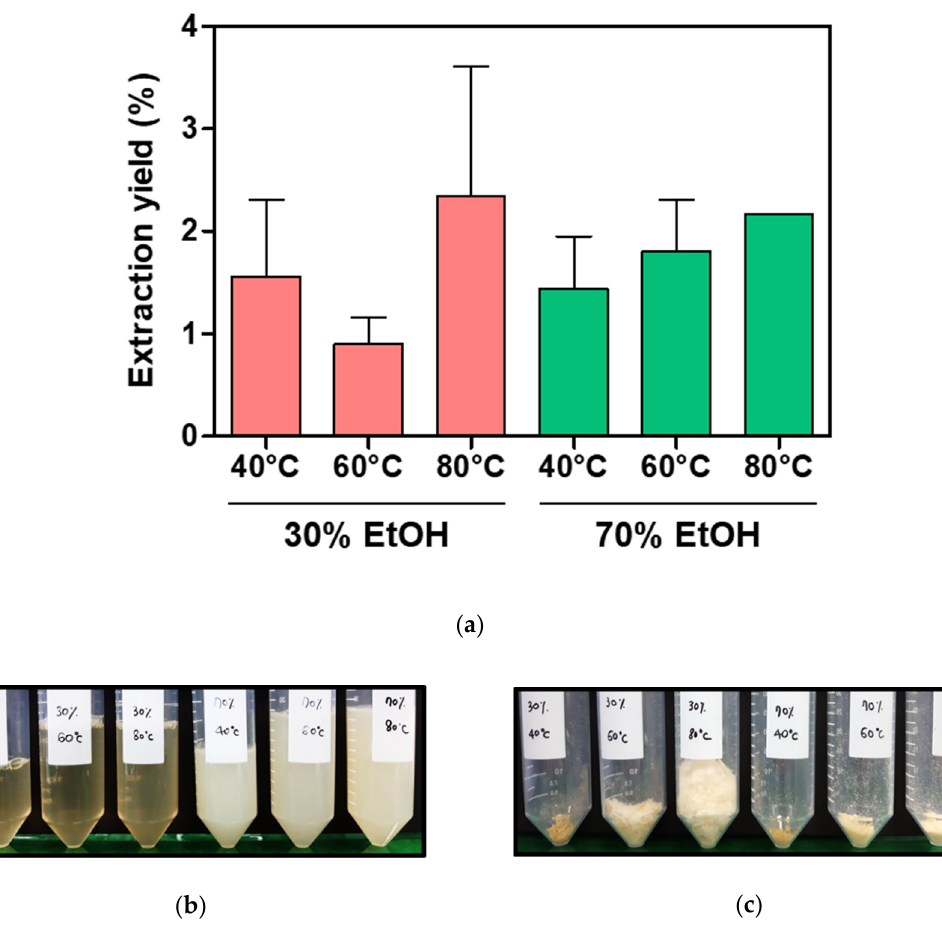
Figure 2. Effects of extraction conditions on the extraction yields and morphologies of cocoon extracts. ( a ) Extraction yields (%) calculated by dividing the solid component in the various extracts by the weight of input cocoons. ( b ) Cocoon extracts solutions after concentration by an evaporator. ( c ) Cocoon extract powders obtained by lyophilization.